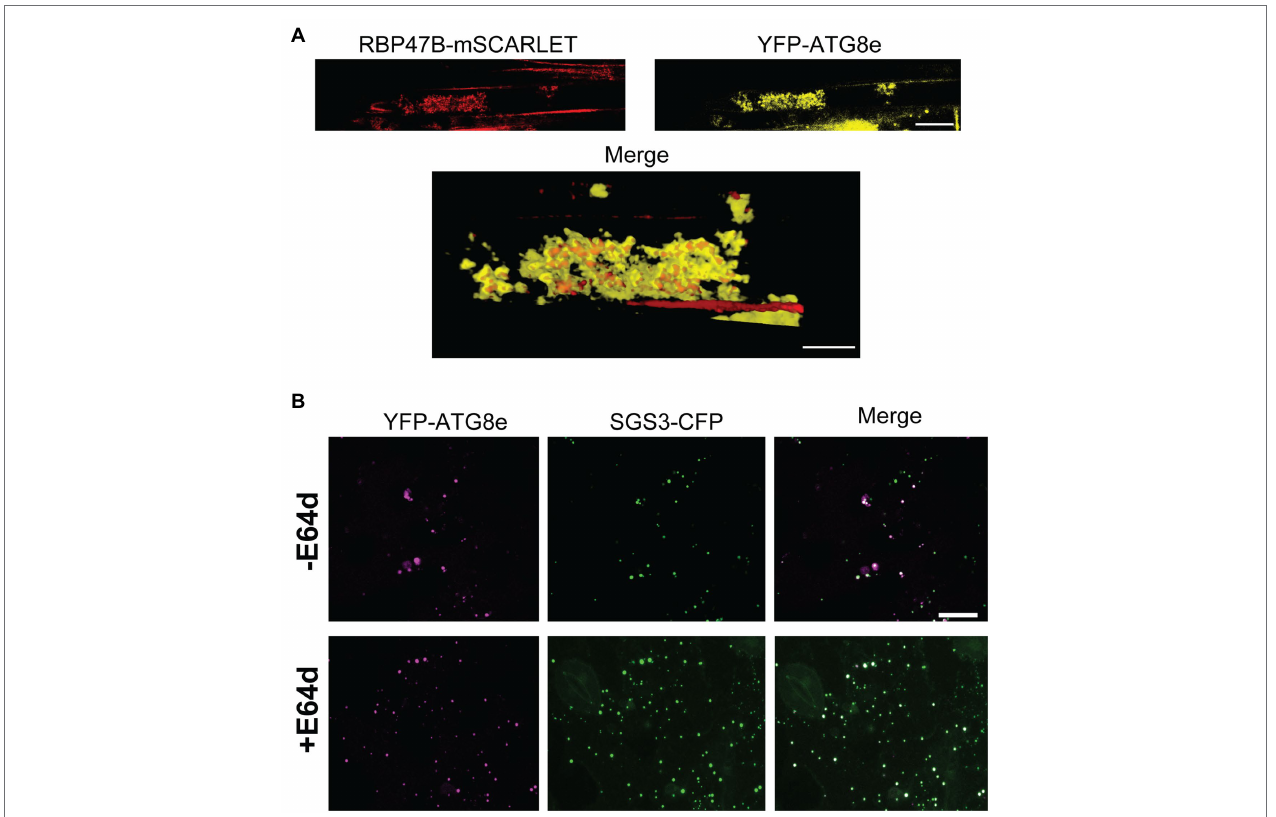
FIGURE 5 | SGS3 and stress granule markers co-localize with ATG8e in E64d-induced autophagic bodies. (A) A transgenic A. thaliana reporter line with RBP47B- mSCARLET and YFP-ATG8e transgenes was subjected to 24 h hypoxia in the presence of E64d. The top panel shows a representative confocal micrograph illustrating the accumulation of both signals within fluorescent clusters similar to autophagic bodies. The bottom panel represents a 3D reconstructed merged image illustrating RBP47B and ATG8e co-localization within these clusters. (B) Co-localization experiment with N. benthamiana leaves co-transfected with constructs that express SGS3-CFP and YFP-ATG8e and subjected to 24 h hypoxia. The images represent 2D projections of 5–6 optical sections (2 μ m/section). +E64d, leaf sections were incubated with 10 μ M E64d. − E64d, control. Scale bars are 25 μ